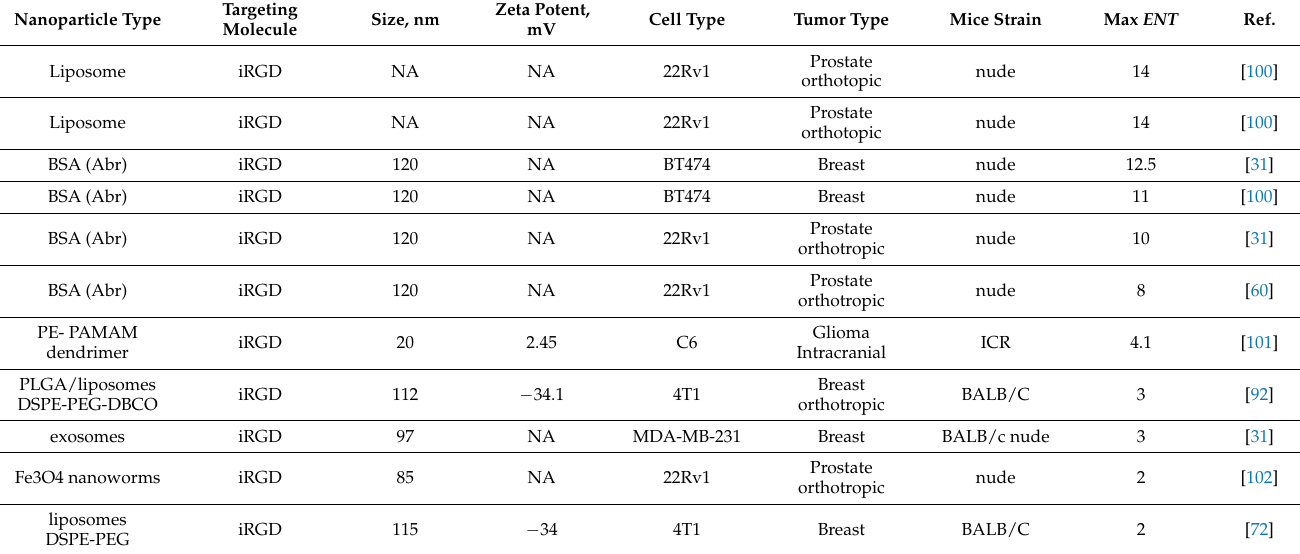
Table 6. Nanoparticles targeted by the iRGD peptide in prostate, breast, and glioma cancers. The data are sorted by the maximum ENT